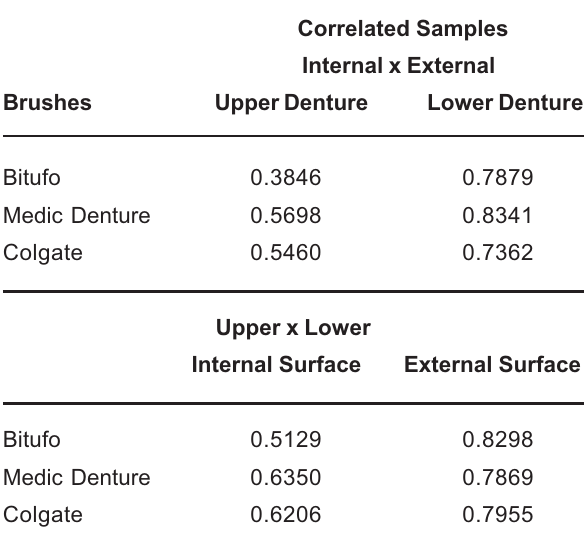
TABLE 3- Results of the Correlation test (r values)